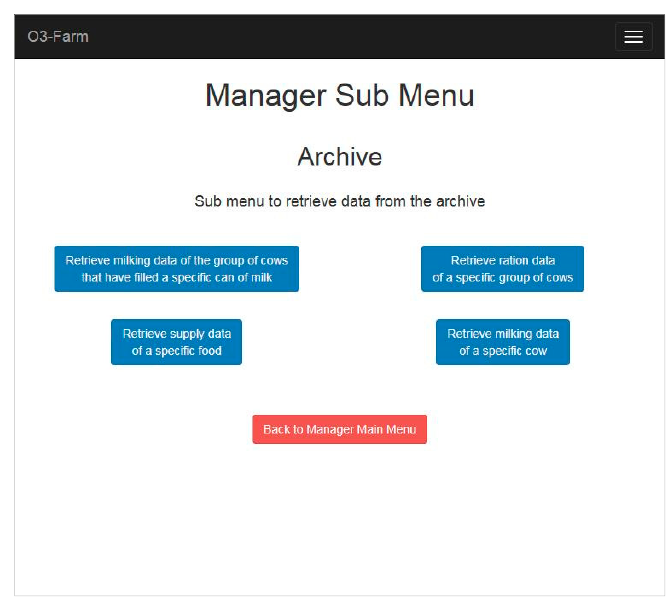
Figure 7. Archive sub-menu available for managers to retrieve milking and agricultural data. Agriculture 2018 , 8 , x FOR PEER REVIEW